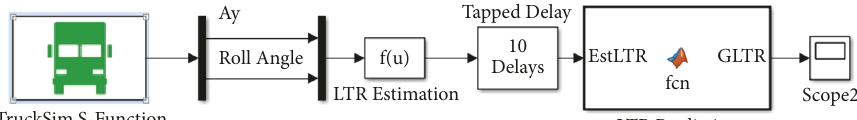
Figure 8: LTR prediction process.